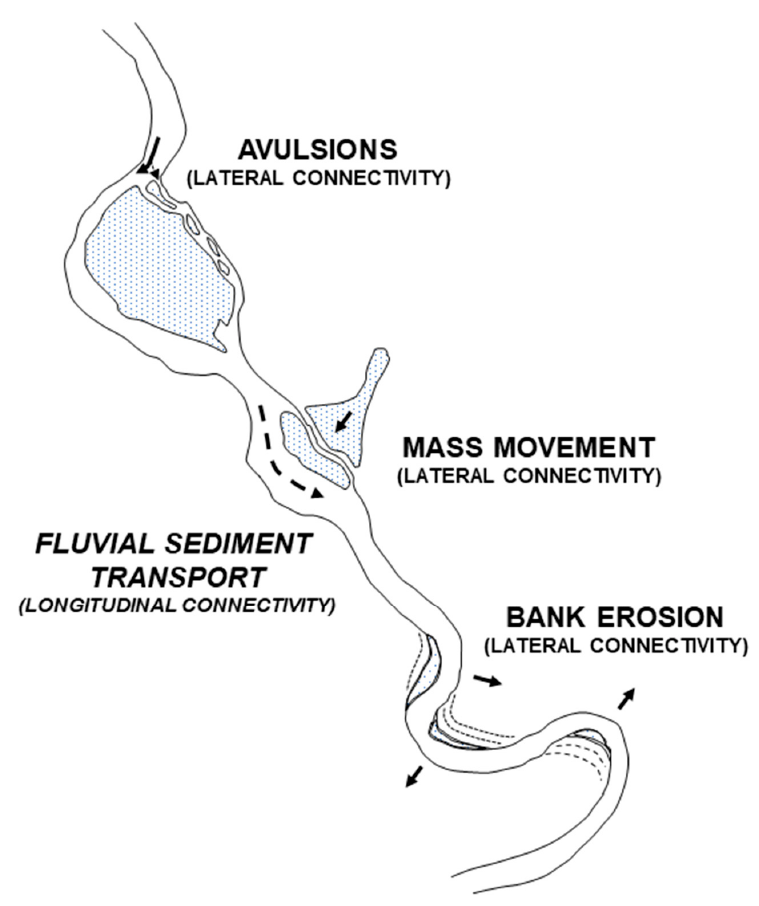
Figure 3. Geomorphic connectivity types, as defined in this review.